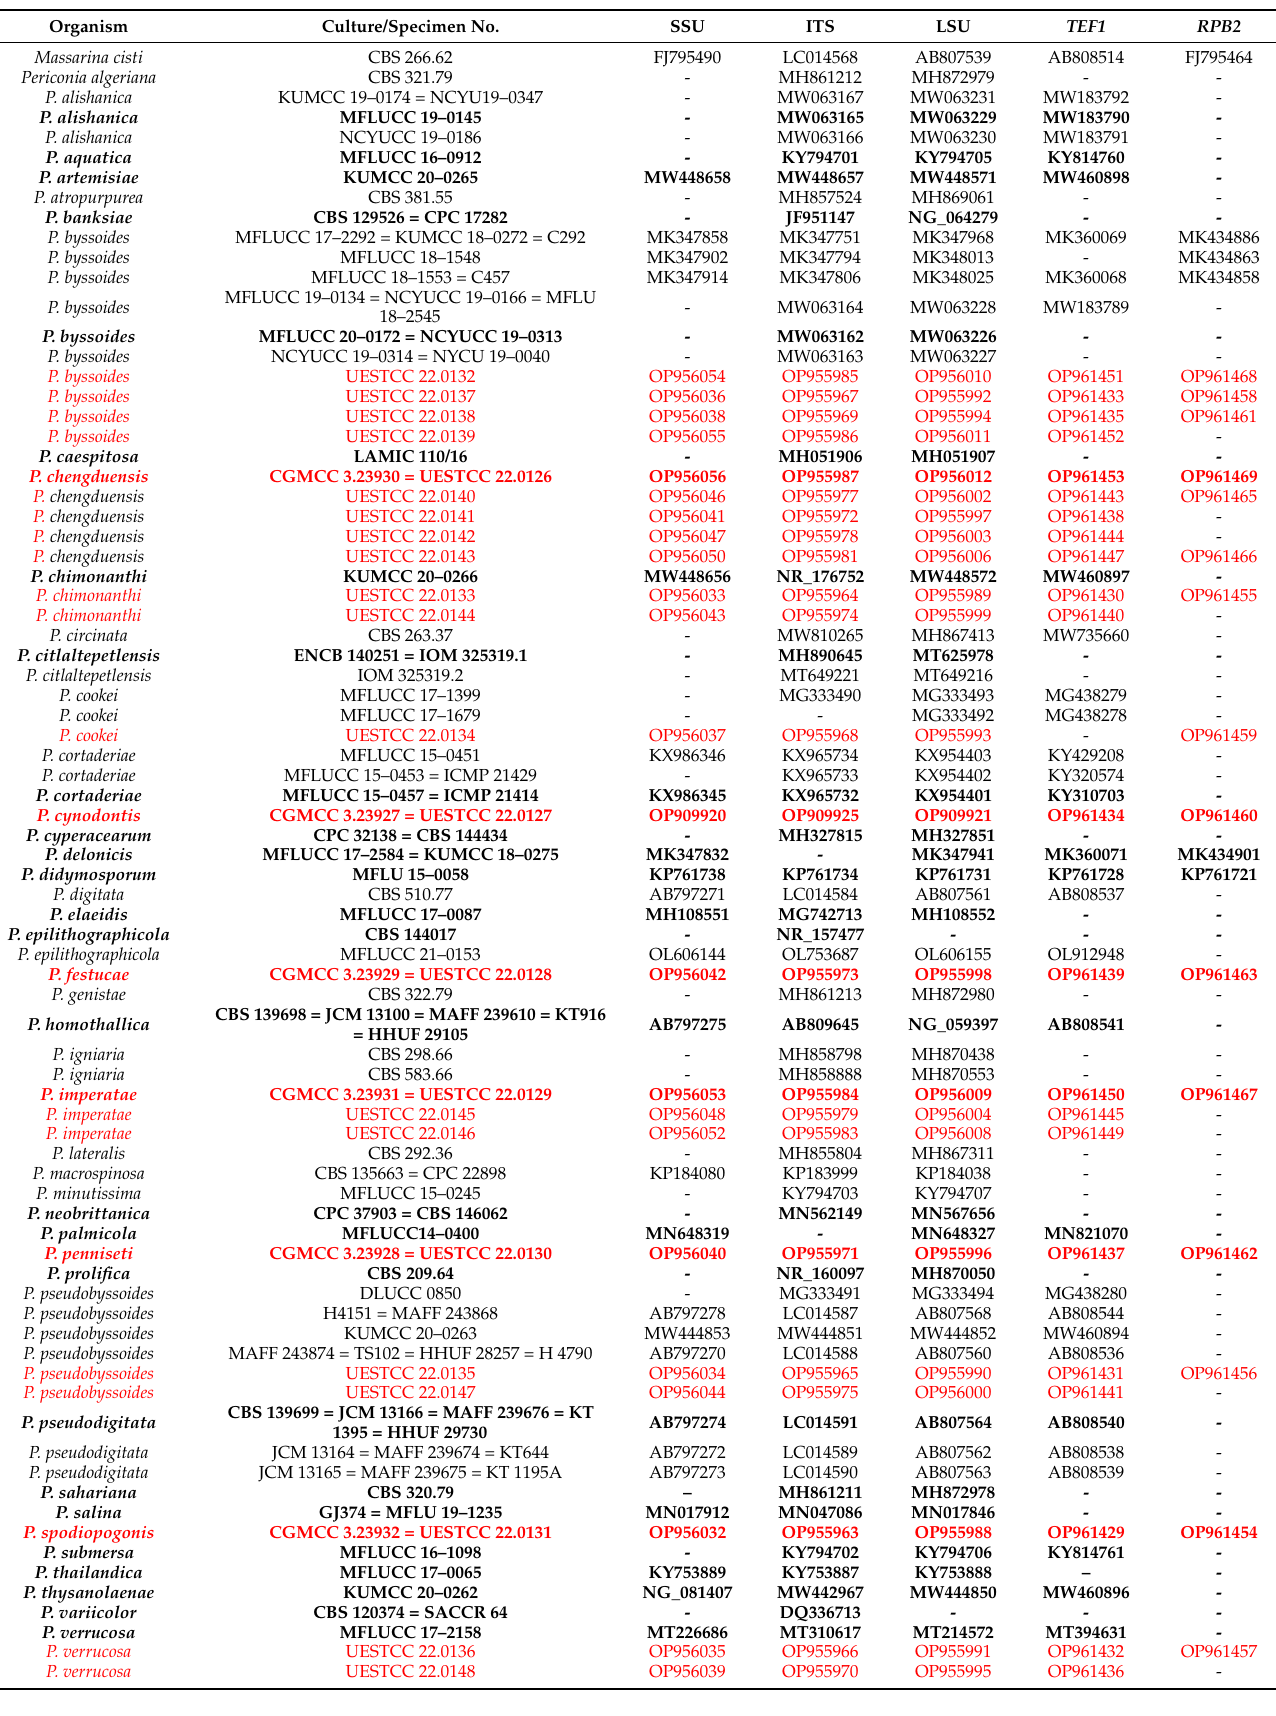
Table 2. Species details and their GenBank accession numbers used in phylogenetic